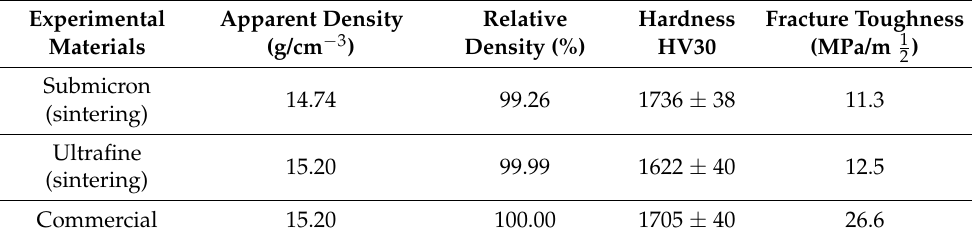
Table 2. Basic properties of the tested